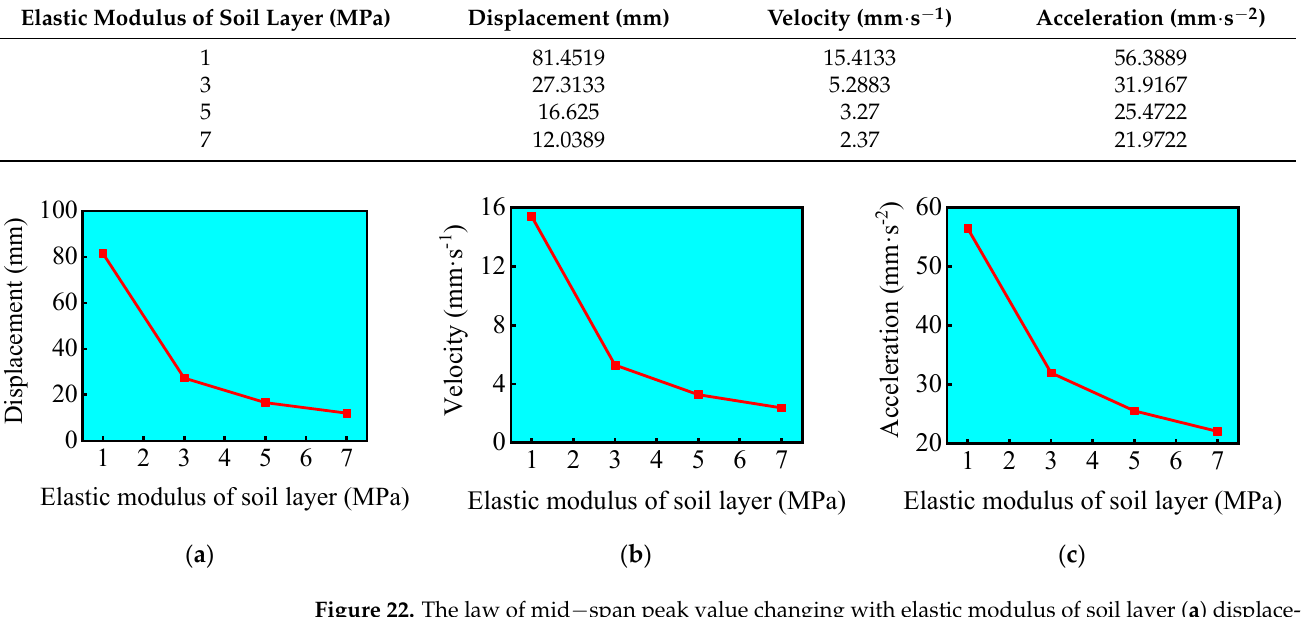
Figure 22. The law of mid − span peak value changing with elastic modulus of soil layer ( a ) displace- ment, ( b ) velocity, and ( c ) acceleration.